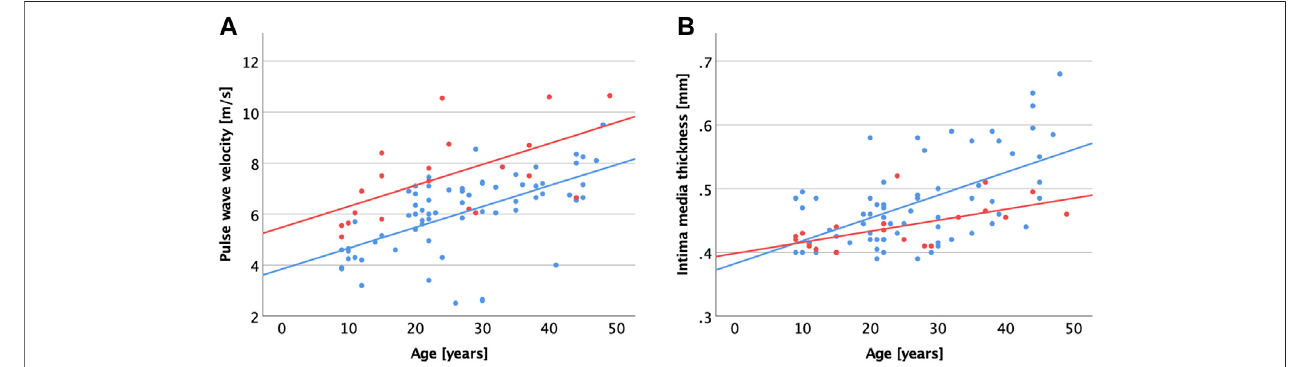
FIGURE 2 | Scatter plot visualizing correlations between age and carotid-femoral pulse wave velocity (A) , common carotid intima media thickness (B) for patients with MFS (red dots and regression line) and healthy controls (blue dots and regression line).